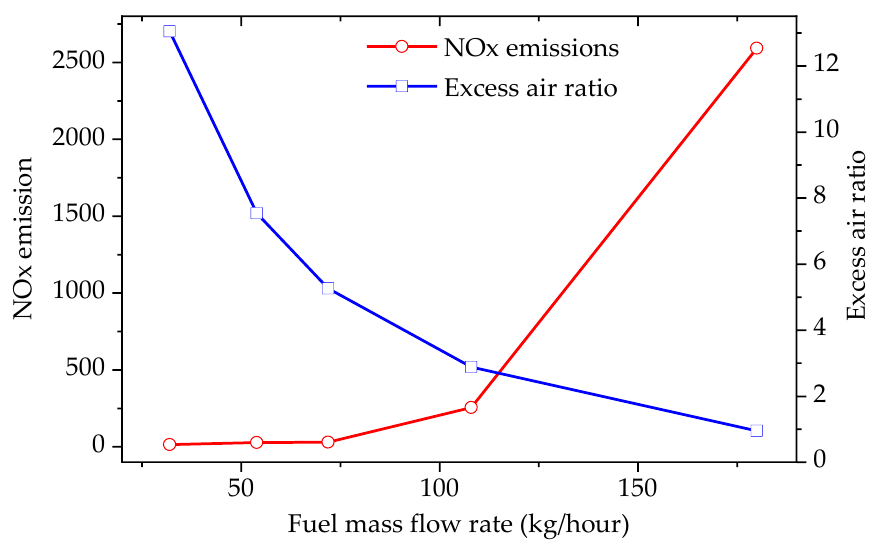
Figure 12. NOx emission and excess air ratio at different fuel mass flow rates ( z = 3 m).